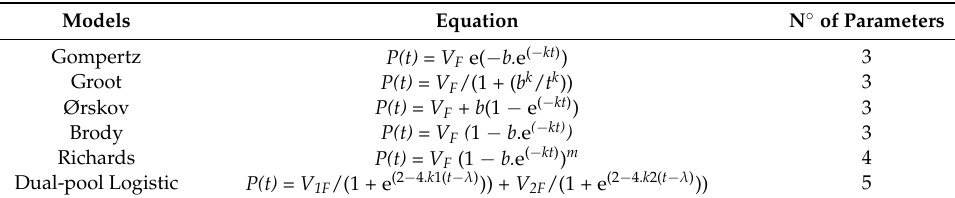
Table 2. Nonlinear models considered in this study to describe the in vitro gas production of corn silage combined with different feed